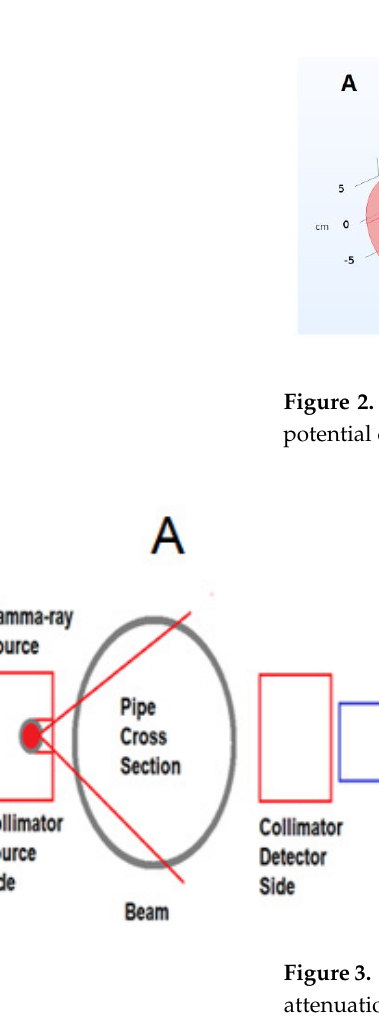
Figure 3 . ( A ) Gamma-ray technique for multiphase flow measurements. ( B ) Simulation of gamma- ray attenuation sensor .